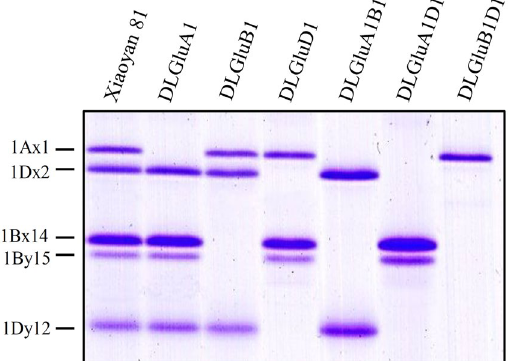
Figure 1. Composition of HMW-GSs in Xiaoyan 81 and six derivative deletion mutants. Xiaoyan 81 is the wild type progenitor, has all three Glu-1 loci ( Glu-A1 , -B1 and -D1 ), and expresses five HMW-GSs (1Ax1, 1Dx2, 1Bx14, 1By15 and 1Dy12). DLGluA1, DLGluB1 and DLGluD1 are single deletion mutants lacking Glu-A1 , -B1 and -D1 , respectively. DLGluA1B1, DLGluA1D1 and DLGluB1D1 are double deletion mutants lacking Glu-A1 / Glu-B1 , Glu-A1 / Glu-D1 and Glu-B1 / Glu-D1 , respectively. The HMW-GSs missed in the six mutants are 1Ax1 (DLGluA1), 1Bx14 + 1By15 (DLGluB1), 1Dx2 + 1Dy12 (DLGluD1), 1Ax1 + 1Bx14 + 1By15 (DLGluA1B1), 1Ax1 + 1Dx2 + 1Dy12 (DLGluA1D1), and 1Bx14 + 1By15 + 1Dx2 + 1Dy12 (DLGluB1D1), respectively.